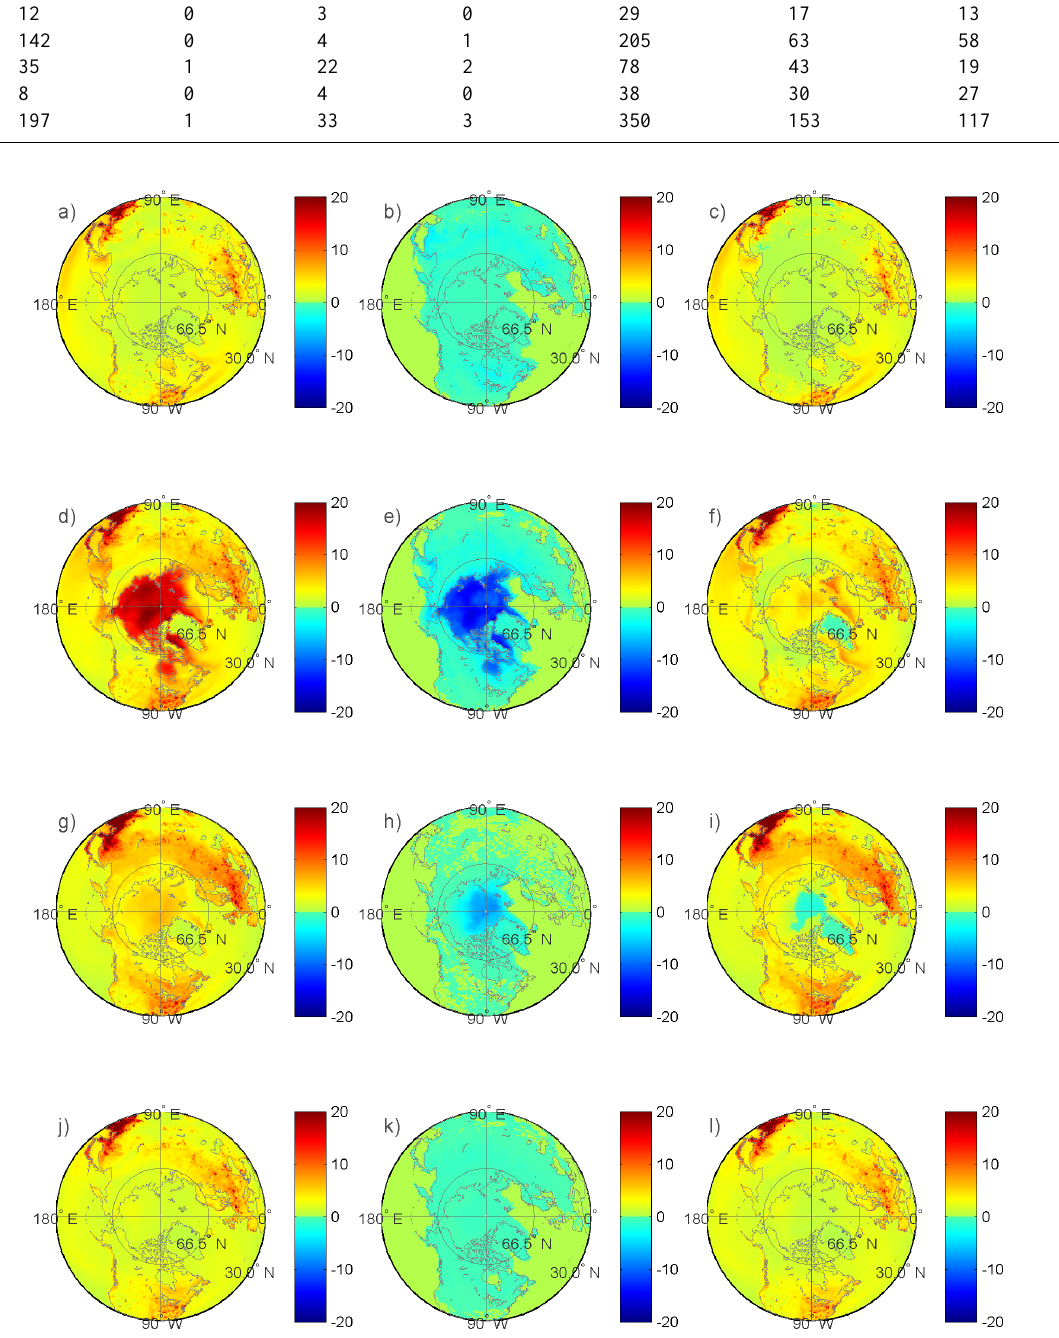
Fig. 6. From left to right by column are, in µgm − 2 , gross deposition (a, d, g, j) , the revolatilization from snowpacks and runoff (b, e, h, k) , Fig.%6.%%From%le^%to%right%by%column%are,%gross%deposi.on,%the%revola.liza.on%from%snowpacks%and% and net deposition (c, f, i, l) based on 5yr (2005–2009) of seasonal data from SORun. The first row (a–c) presents data for winter (December through February), followed by spring (d–f) , summer (g–i) , and fall (j–l)